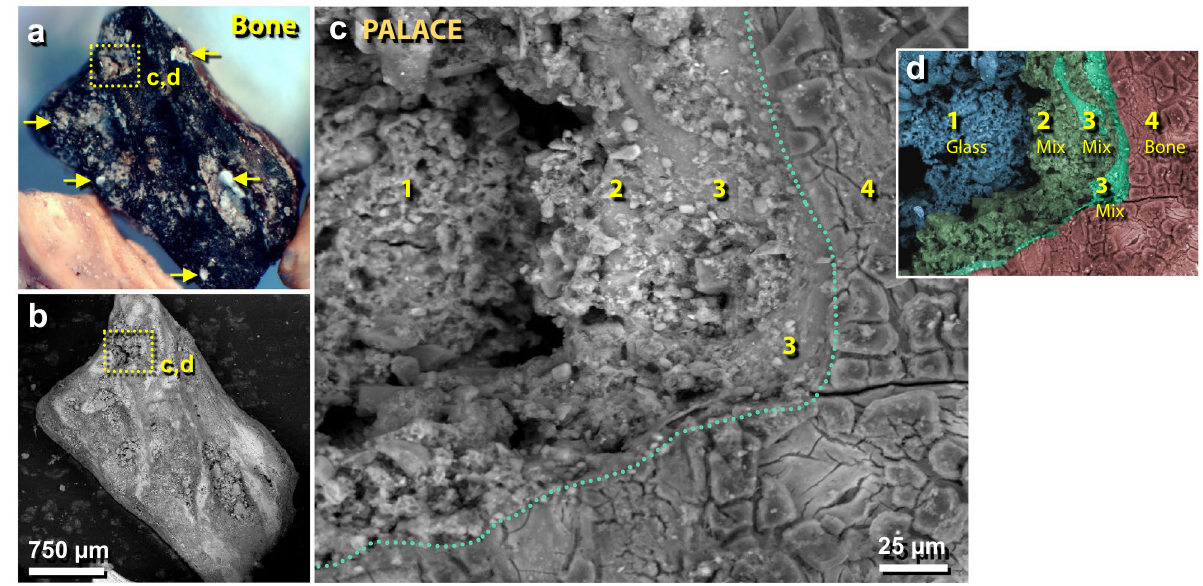
Figure 45. Bone fragment splattered with meltglass in the destruction layer. ( a ) Photomicrograph of 3.5-mm-long charred bone from the palace. The yellow boxed area indicates an area of melted glass on bone, as shown in panels ‘ c ’ and ‘ d ’. Yellow arrows point to other areas with greenish meltglass fused to the bone. ( b ) SEM image of bone in panel ‘ a ’. ( c ) SEM close-up image of boxed area in panel ‘ a ’. Green dotted line marks the glass-to-bone boundary, as further shown in panel ‘ d ’. #1 represents unmelted Ca–Al–Si-rich sediment with no bone component; #2–3 represent partially melted sediment mixed with melted bone (hydroxyapatite); #4 presents charred bone. ( d ) Colorized SEM image of panel ‘ c ’ showing gradation of bone-and-sediment mixing, based on multiple SEM–EDS